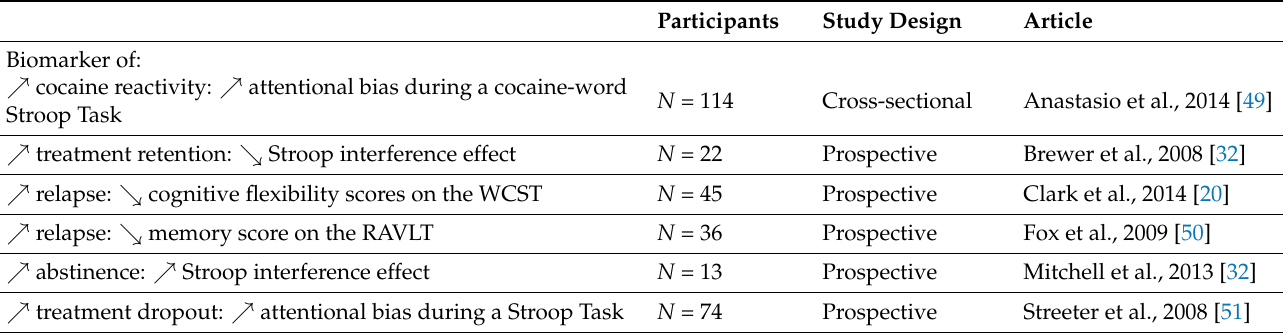
Table 2. Neuropsychological and cognitive challenges. Participants Study